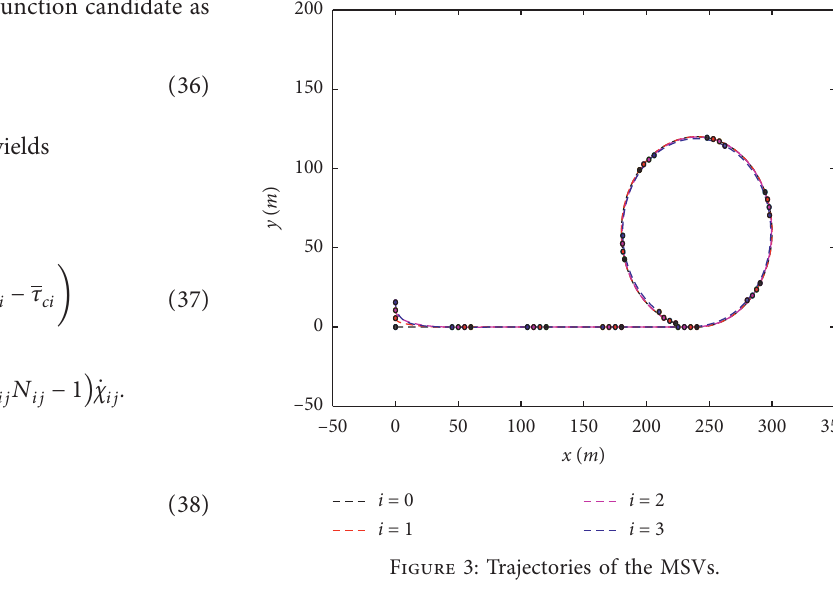
Figure 3: Trajectories of the